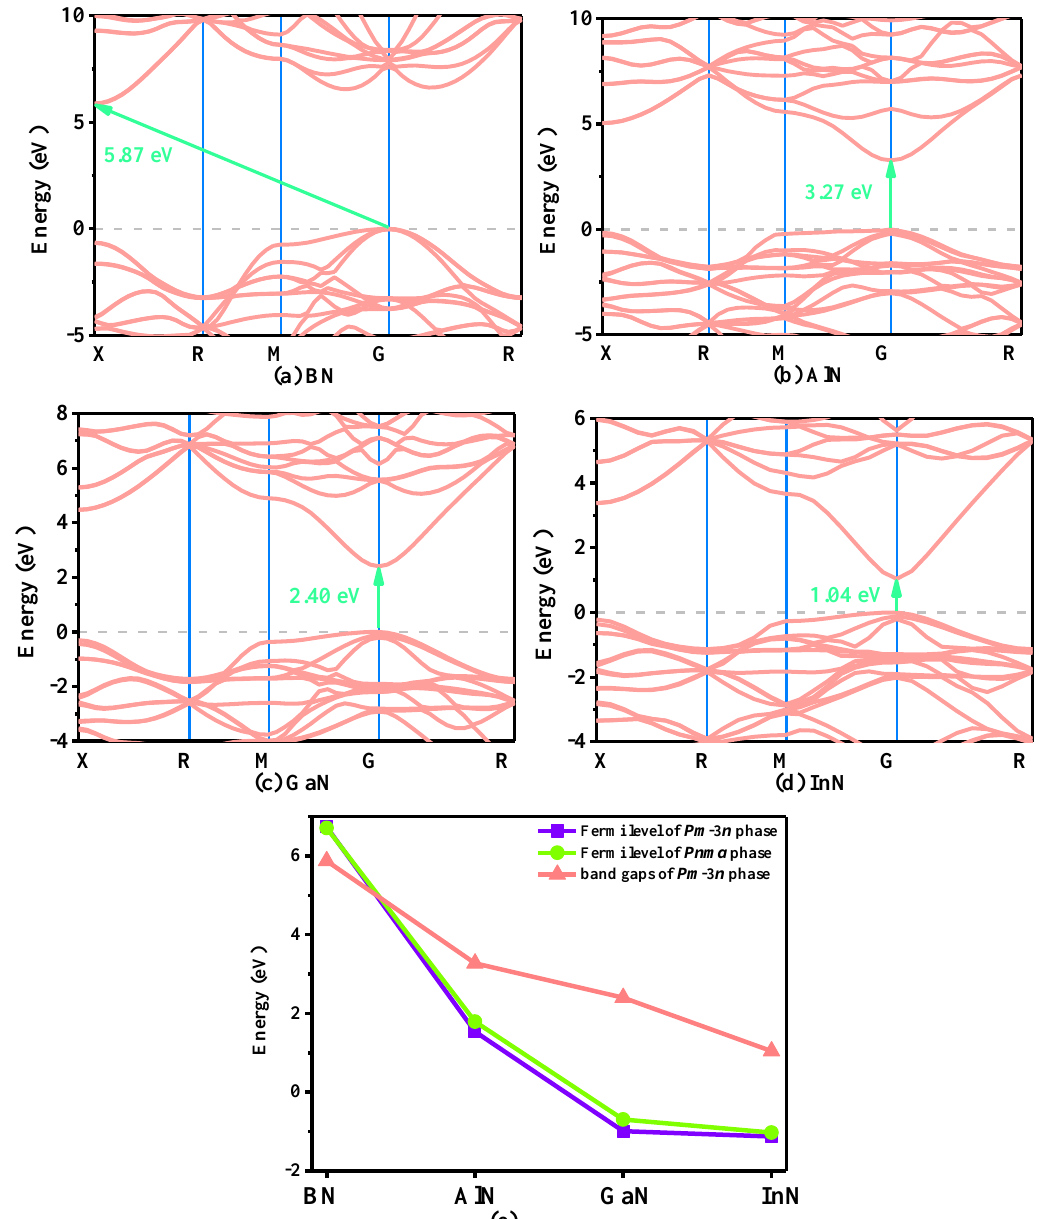
Figure 8. The electronic band structures for BN ( a ), AlN ( b ), GaN ( c ), and InN ( d ), in the Pm − 3 n phase, and Fermi level of Pm − 3 n and Pnma phases ( e ) .